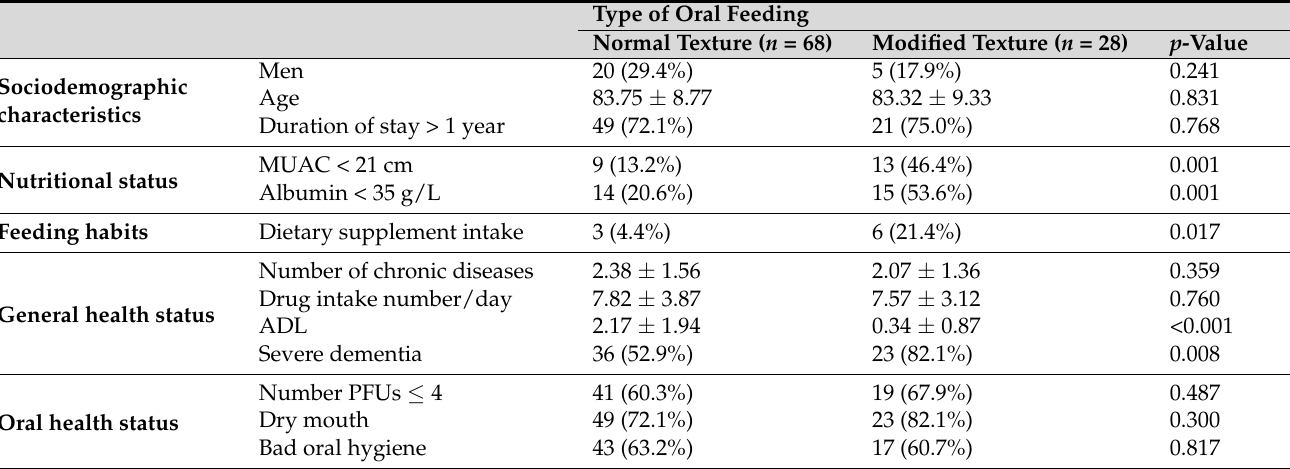
Table 4. Analysis of type of oral feeding with sociodemographic characteristics, nutritional status, feeding habits, and general health status and oral health status. Type of Oral Feeding Normal Texture ( n = 68) Modified Texture ( n = 28) p